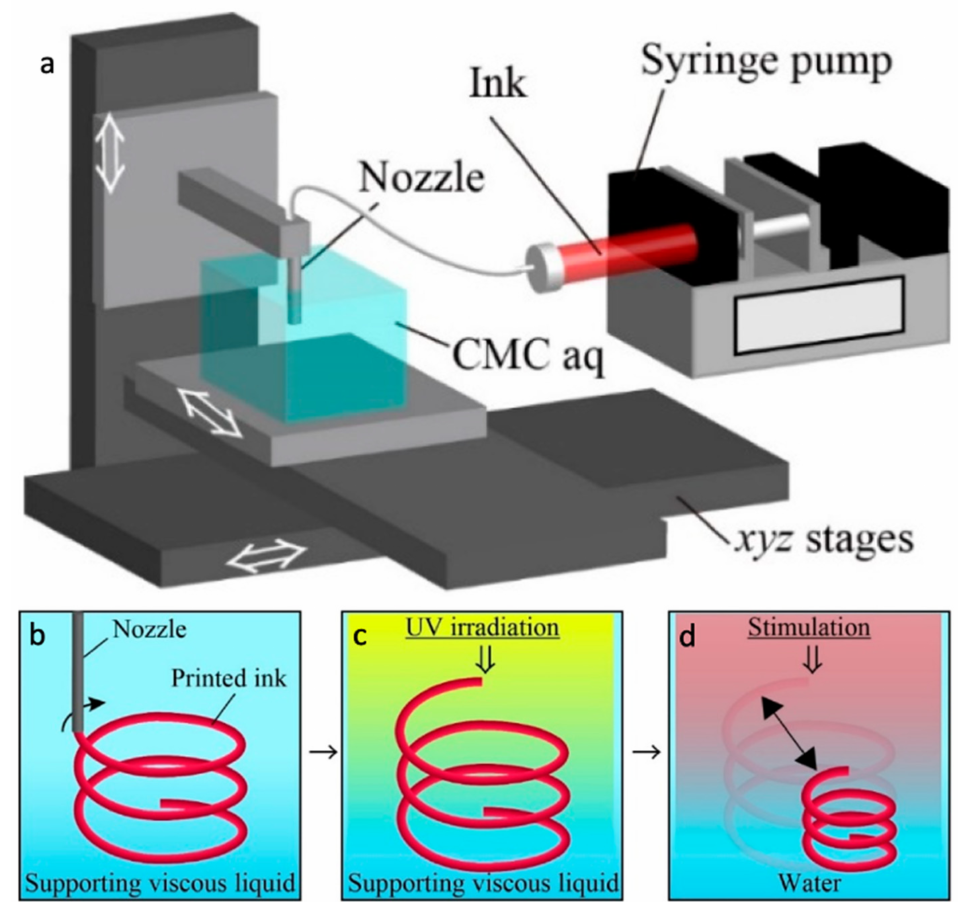
Figure 6. ( a ) Schematic diagram of a 4DP system. It is showing that a nozzle is secured on a z stage, and a vessel of carboxymethyl cellulose aq (CMC aq) is secured on xy stages. By stirring the xyz stages, the pre-gel ink is deposited through the nozzle into CMC aq using a syringe pump. Concept for printing 4D object with internal gaps. ( b ) Pre-gel monomer ink is deposited into auxiliary viscous liquid to print a 3D ink design. ( c ) The written ink is subjected to UV light and is polymerized to acquire a 3D hydrogel assembly. ( d ) Afterward substituting the auxiliary liquid into water, the polymerized 3D hydrogel assembly collapses in reaction to UV light. Reprinted with permission from reference [61], Copyright 2020 by the authors and license MDPI, Basel,